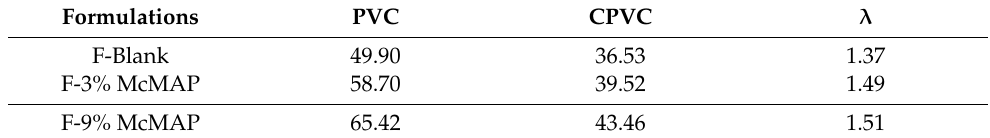
Table 4. Pigment volume concentrations (PVC), critical PVC (CPVC), and λ values for the